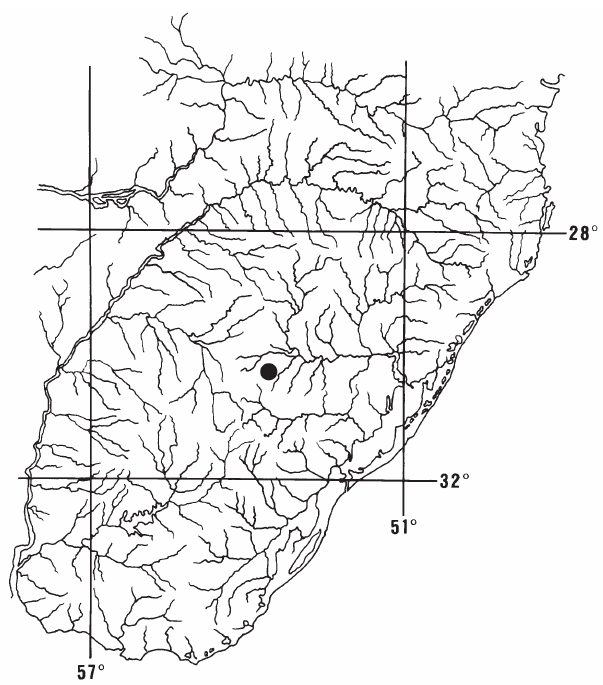
Fig. 4. Southern Brazil and Uruguay, showing the type local- ity (black circle) of Austrolebias paucisquama